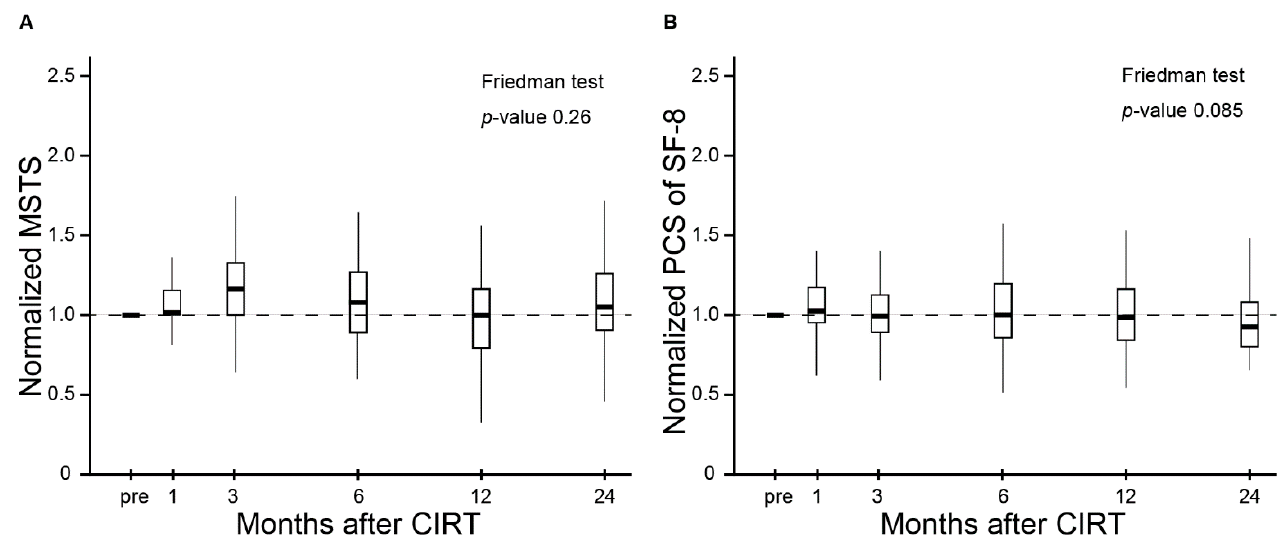
The MSTS score and QOL scores (PCS and MCS of SF-8) were used to assess the effect of CIRT on QOL and functional outcomes in patients with inoperable BSTS. The normalized MSTS score and normalized PCS and MCS of SF-8 are shown in Figure 2A–C. The median baseline MSTS score, PCS, and MCS of SF-8 were 20.00 [interquartile range (IQR), 14.75–24.25], 41.04 (IQR, 36.44–49.49), and 43.75 (IQR, 36.91–48.08), respectively. The normalized MSTS score and normalized PCS of SF-8 did not change significantly between the baseline and subsequent measurements ( p = 0.26 and 0.085, respectively, Figure 2A,B). The normalized MCS of SF-8 improved significantly after completion of treatment throughout the observation period ( p < 0.001, Figure 2C).